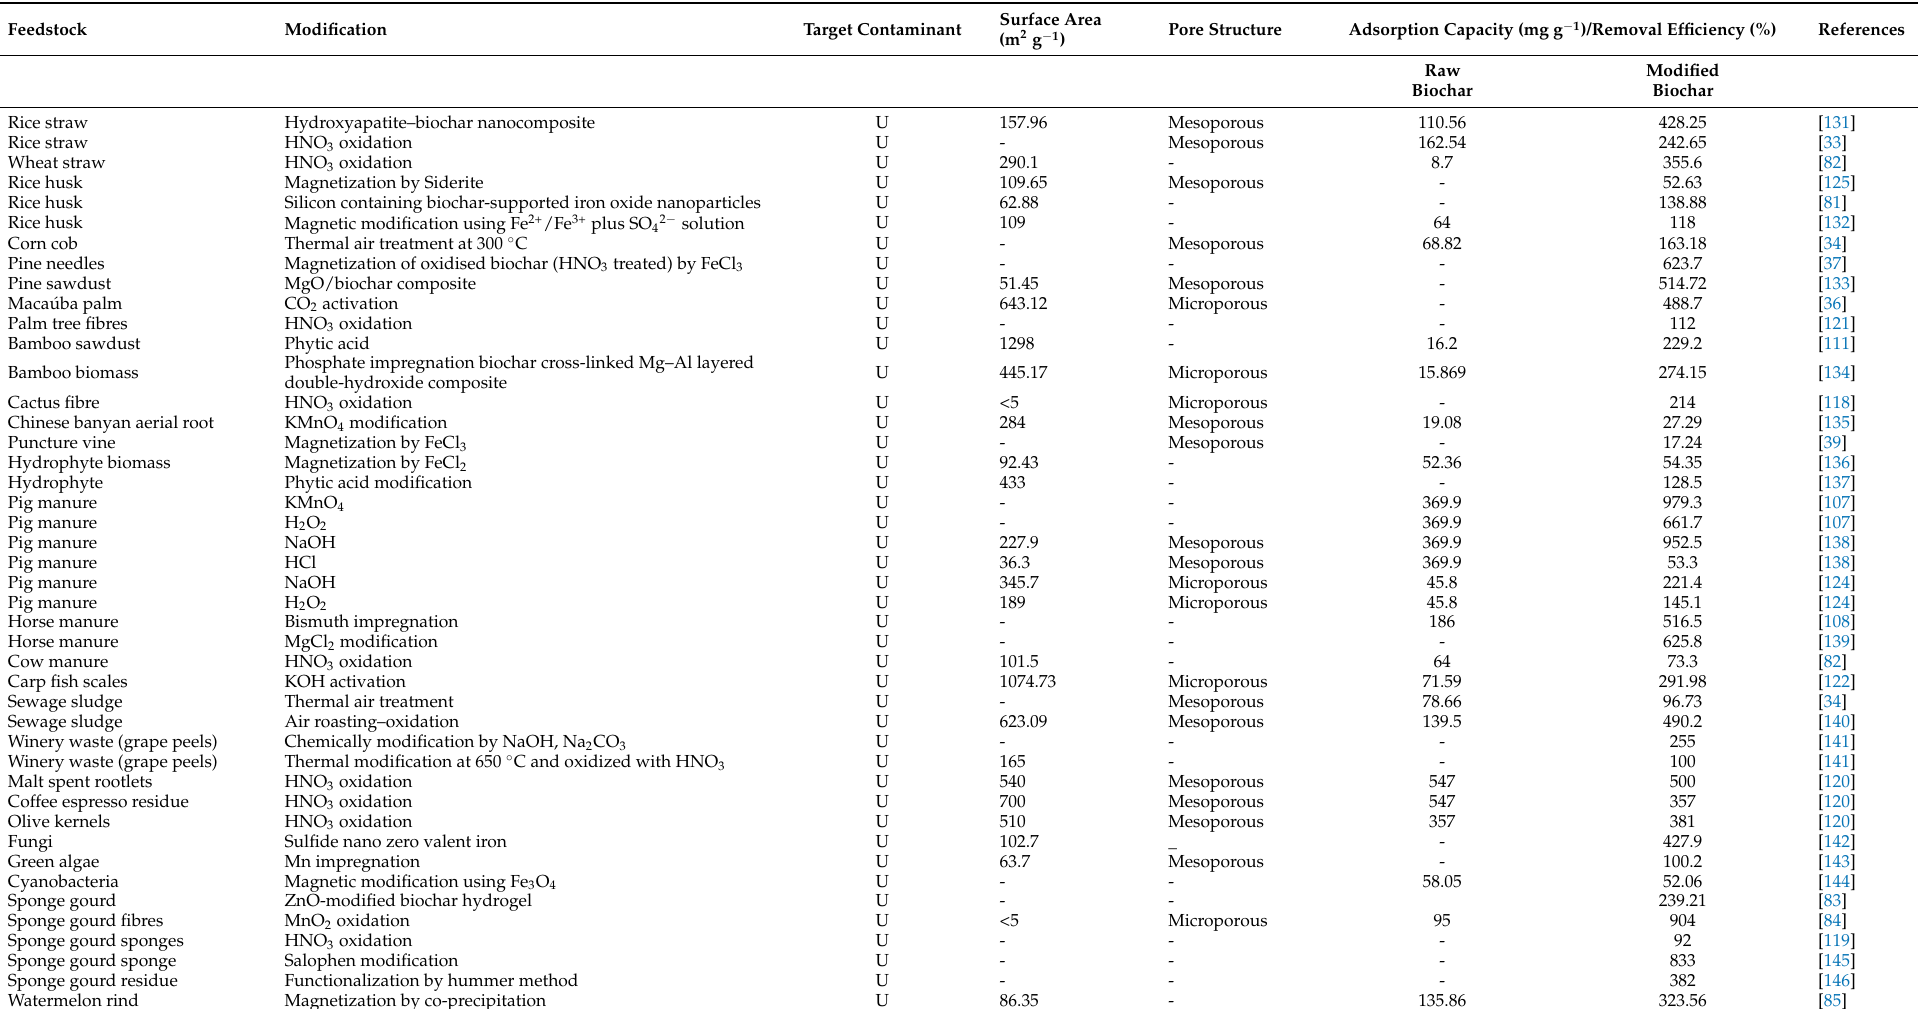
Table 1. Effect of modification on the adsorption capacity of biochar for U and F − removal.